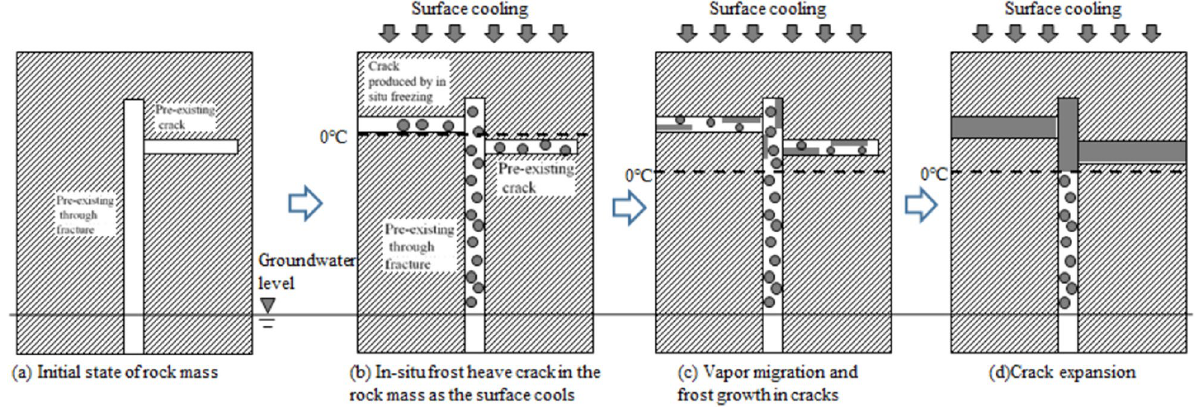
Figure 10. Formation of ice layer by initial crack-condensation